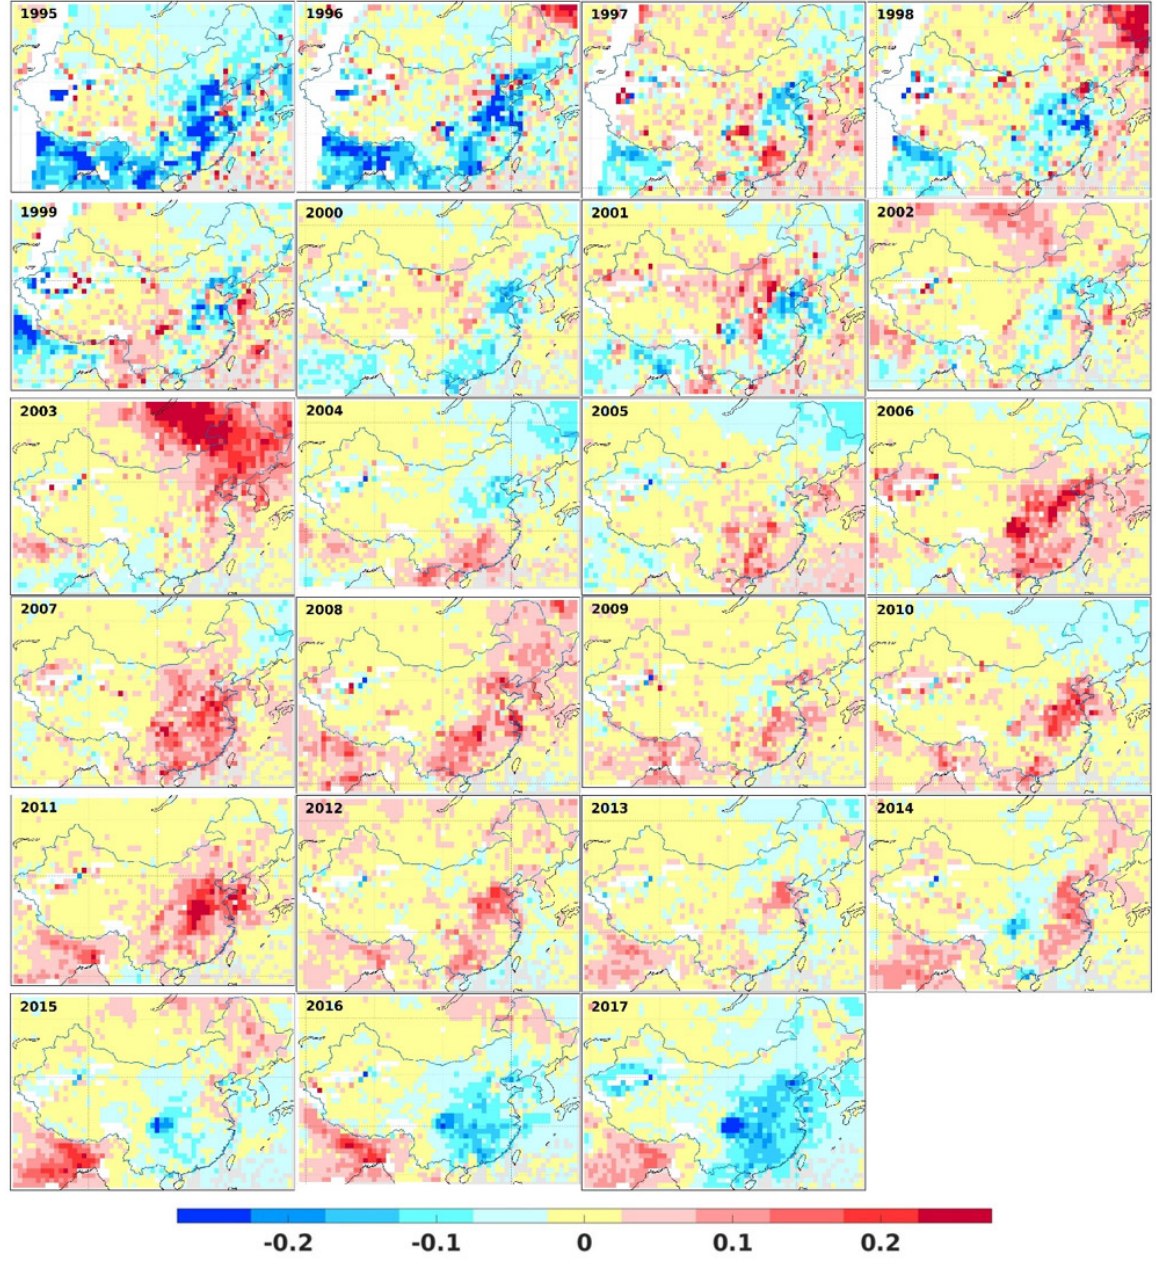
Figure 6. AOD anomaly maps for the years from 1995 to 2017 calculated for combined AOD. Anomalies were calculated for each year by subtracting the multiyear (1995–2017) average from the annual